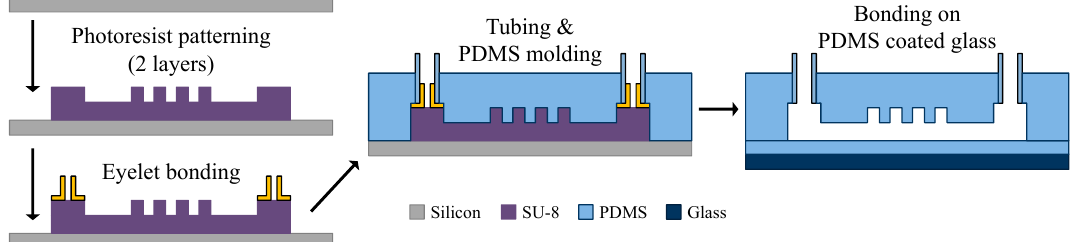
Figure 4. The fabrication process of the sorting device.